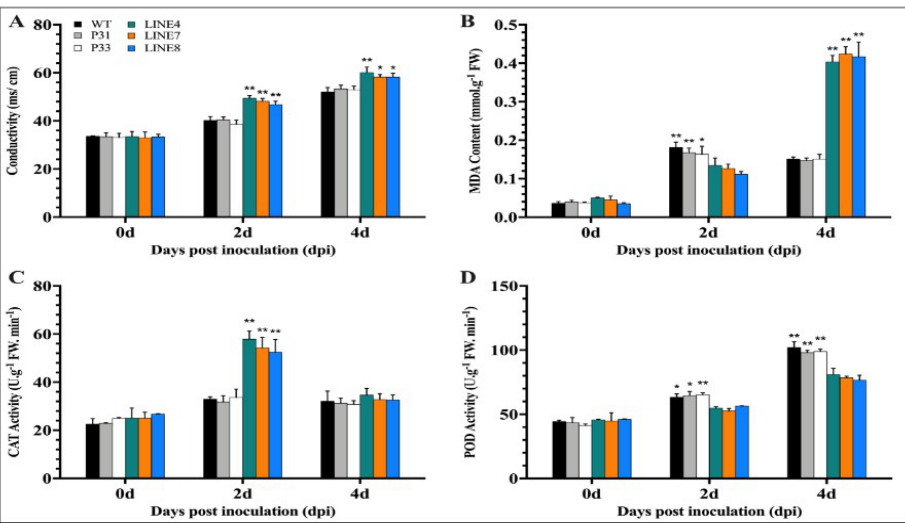
Figure 10. Determination of biochemical indexes of transgenic (line 4, line 7, and line 8), empty vector (P31, P33), and wild-type lines after inoculation with P. capsici. ( A ) Conductivity of the transgenic, empty vector, and wild-type lines. ( B ) MDA content of the transgenic, empty vector, and wild-type lines. ( C ) Catalase (CAT) activity of the transgenic, empty vector, and wild-type lines. ( D ) peroxidase (POD) activity of the transgenic, empty vector, and wild-type lines. Data was analyzed between the transgenic lines (line 4, line 7, and line 8) and the wild-type and empty vector transgenic lines (P31 and P33) at the same time point using the least significant difference (LSD). ** or * in the figure indicates that transgenic lines (line 4, line 7, and line 8) had a significant difference (at p ≤ 0.01 or p ≤ 0.05) compared with control lines (wild-type and empty vector transgenic lines P31 and P33) at the same time point. Mean values and SEs for three replicates are shown.